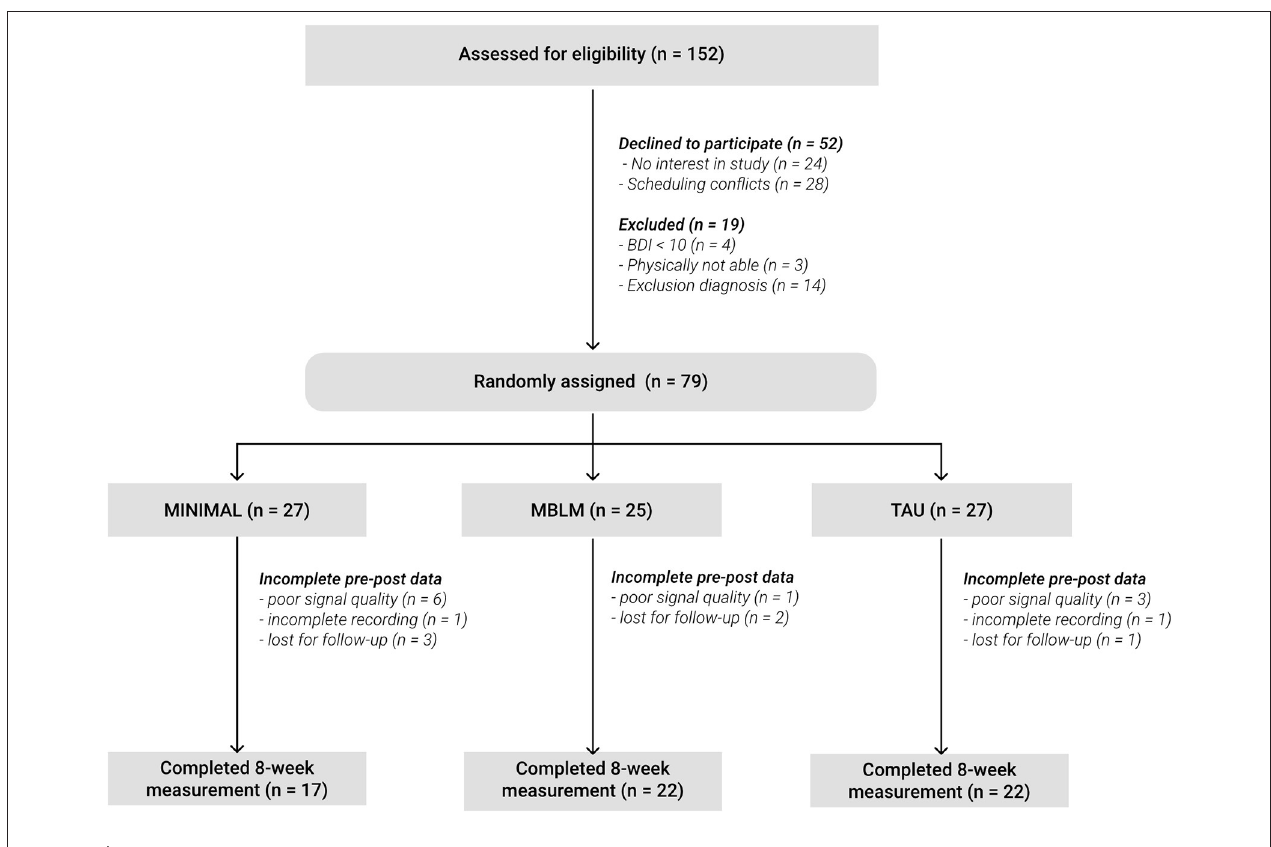
FIGURE 1 | Participant flow.